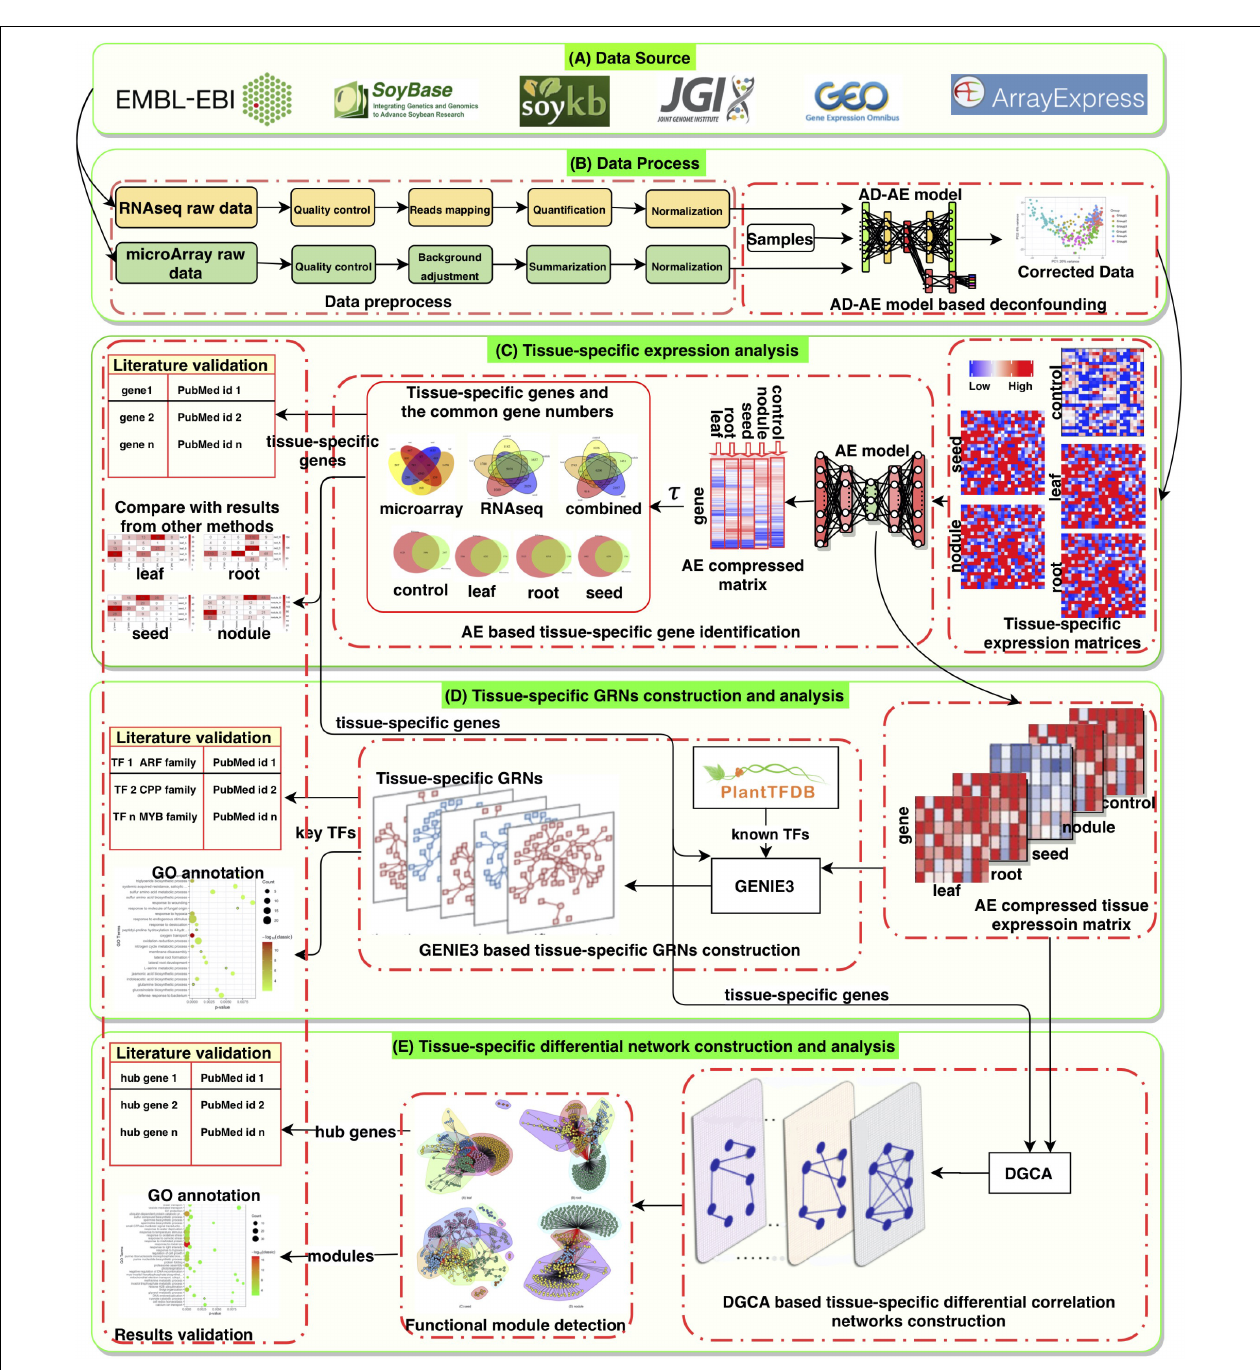
FIGURE 1 | The overall framework and